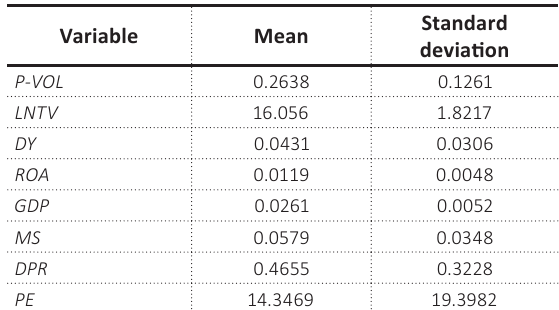
Table 2. Summary statistics